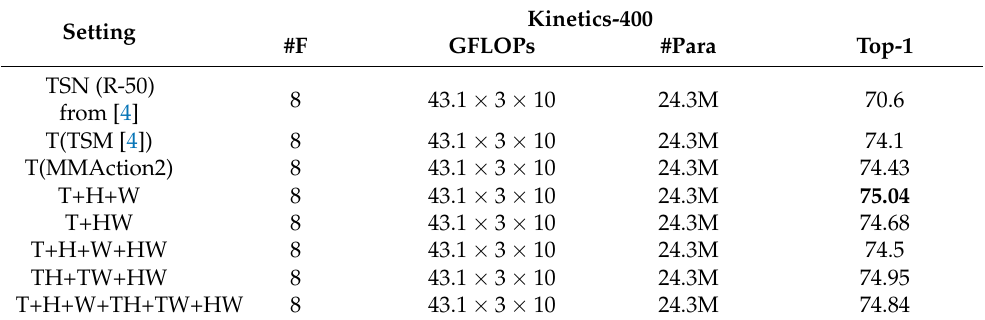
Table 3. Comparison results of network performance under 1D and 2D shift operations. In our method, the α = 3/8. The α for TSM is set to 1/4, consistent with TSM’s original